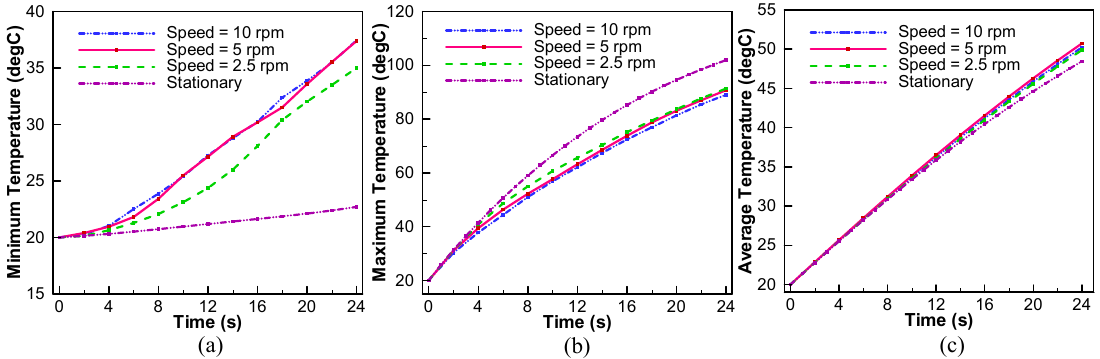
Figure 14. Outline of potato and simulated temperature distributions on the top surface of the cylindrical meshed potato after microwave heating for 24 s with different rotation speeds (top view, unit: °C).